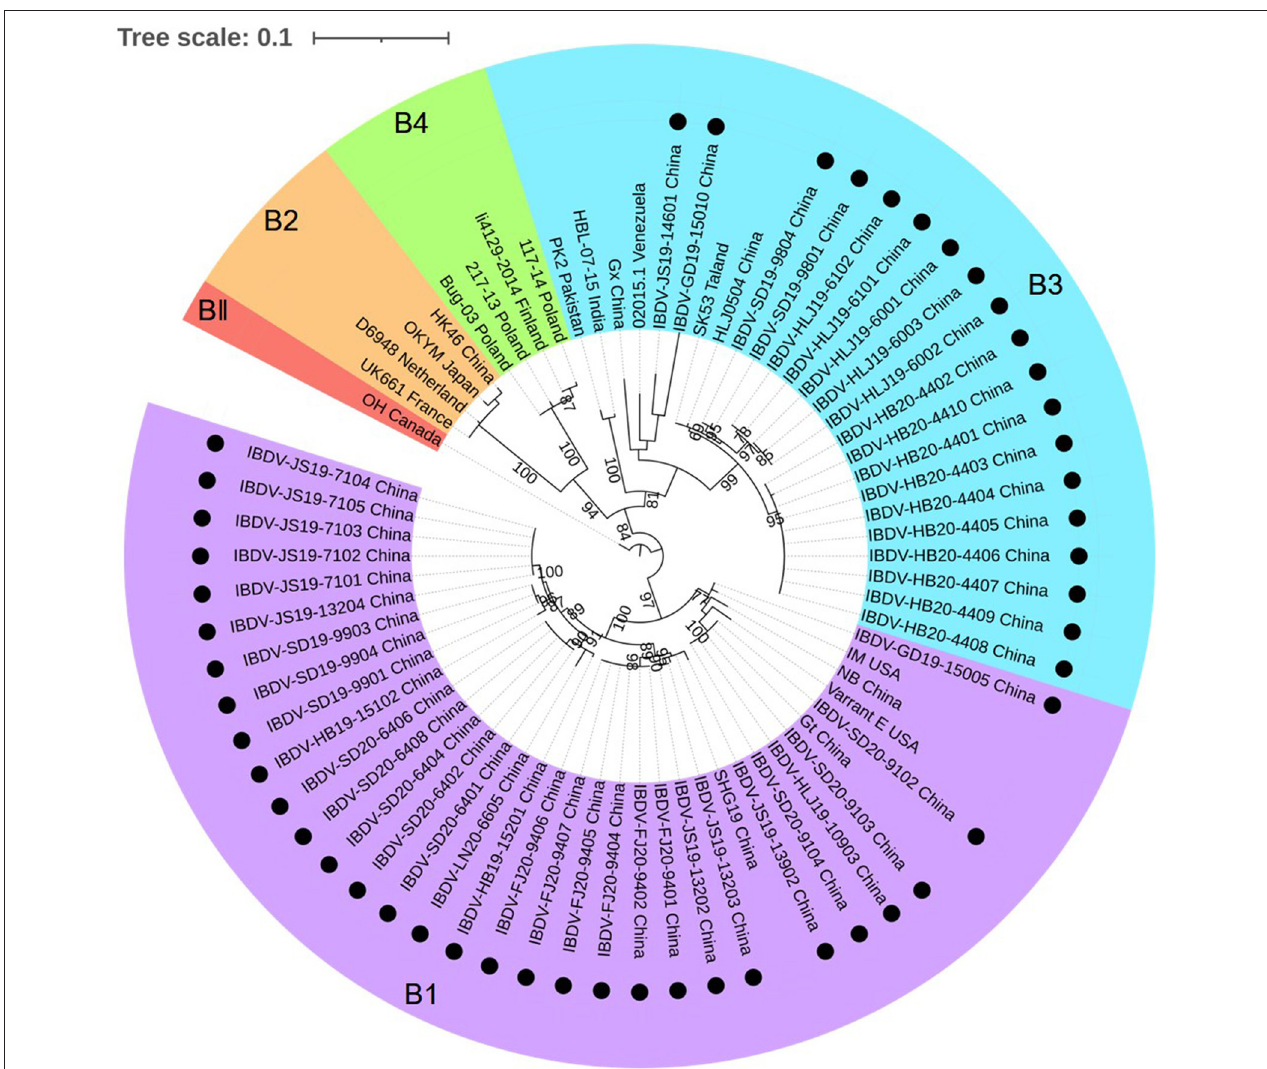
FIGURE 3 | Phylogenetic analysis of the nucleotide sequences of the B-marker of the VP1 gene. The tree was generated by the maximum likelihood method using MEGA6 Software. The tree was visualized in iTOL. The tree was drawn to scale, with branch lengths measured in the number of substitutions per site. Only branches supported by a bootstrap value above 60% were displayed. The analysis involved 20 nucleotide sequences, and 50 strains detected in this study were highlighted with a solid circle (•). Five genogroups based on B-marker of the VP1 gene in segment B were